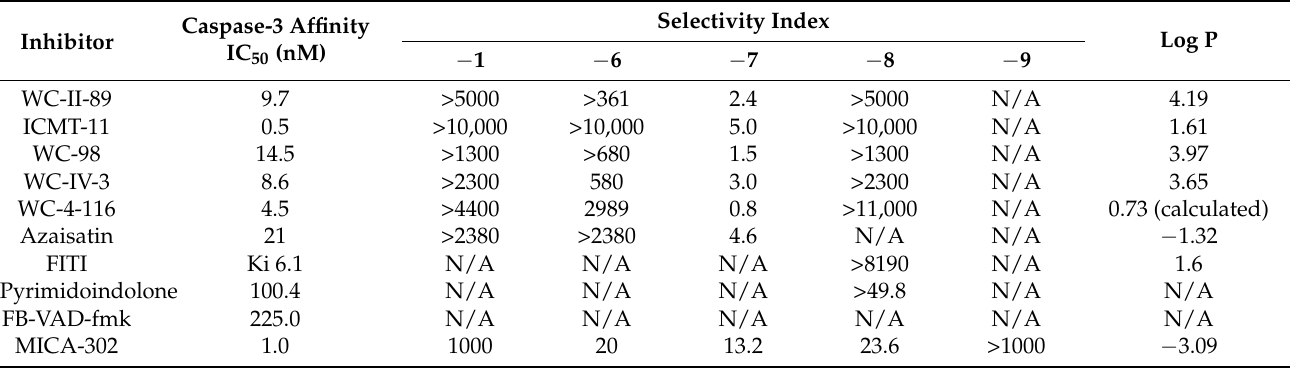
Figure 2. The isatin sulfonamide scaffold. Reprinted with permission from ref. [26]. Copyright 2020 MDPI. Table 1. Caspase-3 affinity of various isatin sulfonamide inhibitors and peptide-based ABPs, their relative selectivity and log